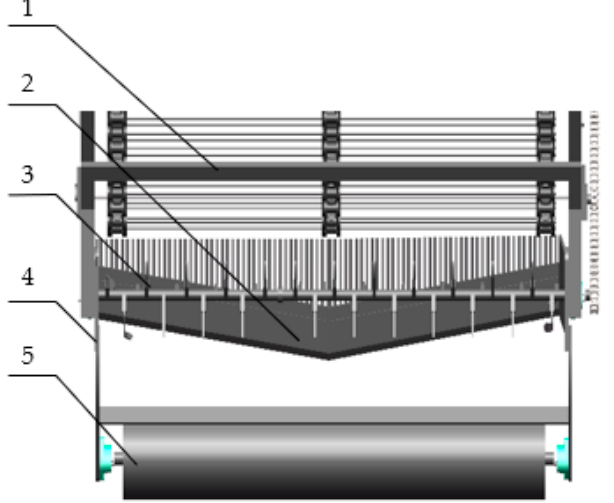
Figure 4. The digging devices. 1. Rack; 2. Digger blades; 3. Soil-breaking blades; 4. Depth-limiting arm; 5. Depth-limiting wheel.